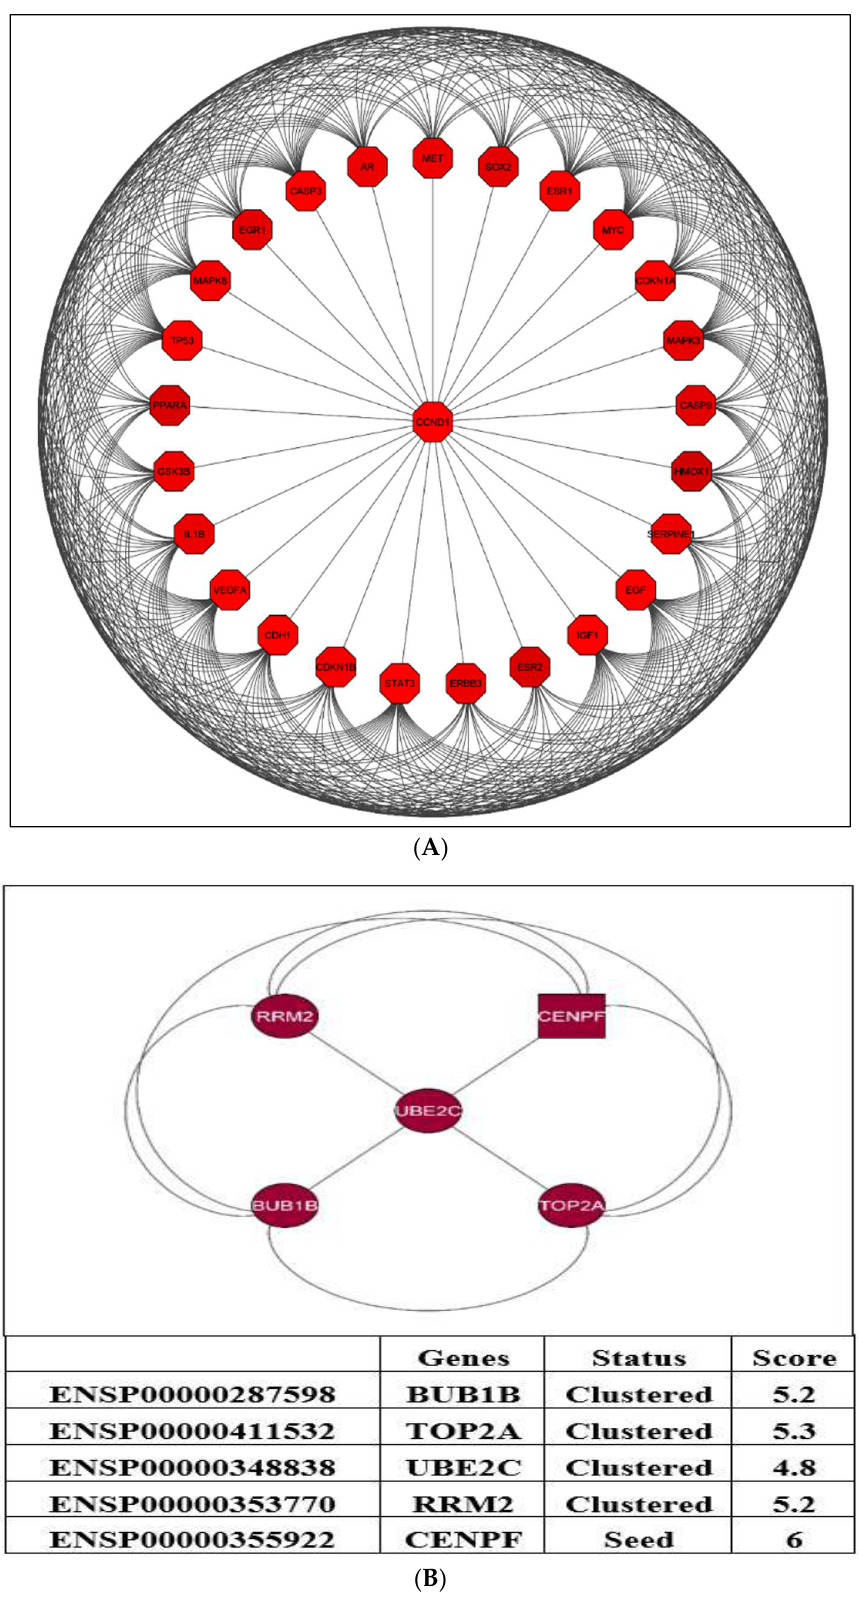
Figure 7. The two modules were generated from the PPI network. ( A ) Module-1: associated with a score of 21.36 and includes 25 genes (nodes) and 175 edges. ( B ) Module-2: associated with a score of 5; consists of five genes (nodes) and 10 edges.